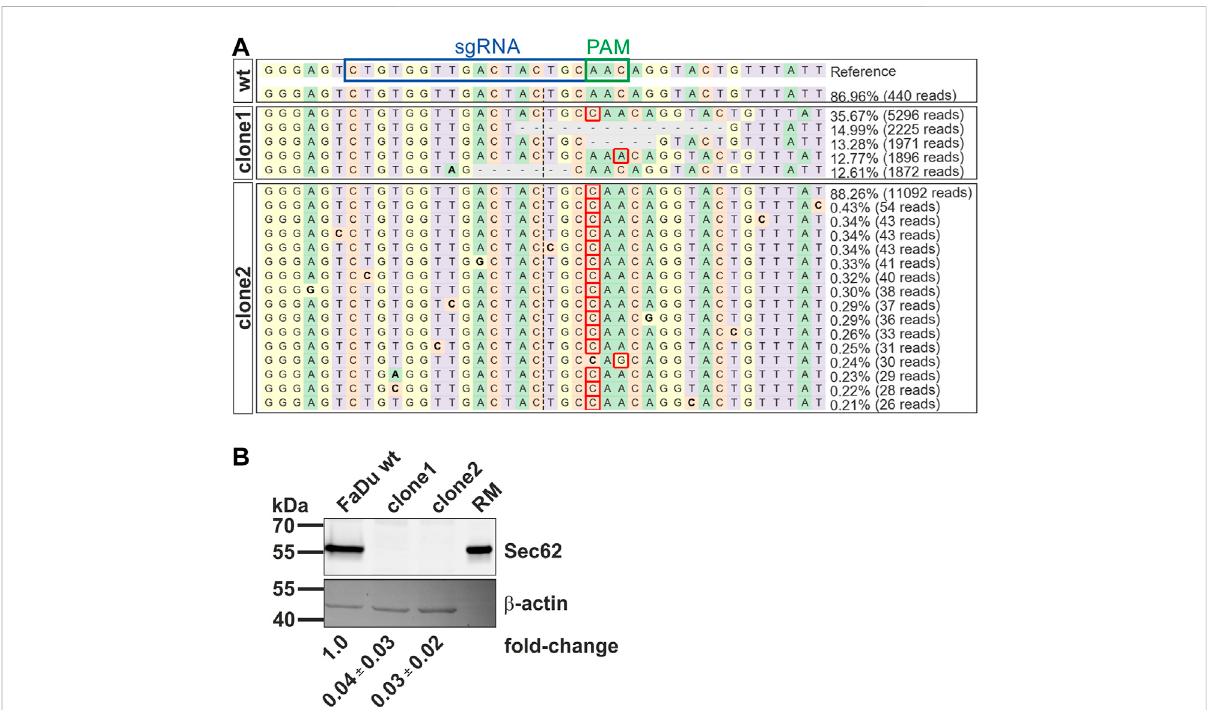
FIGURE 4 Characterization of newly generated SEC62 -knockout FaDu cell clones by CRISPR-Cas9 event. (A) Visualization of identi fi ed alleles by NGS around the Cas9 cleavage site. Each sequenced nucleotide was marked by a unique colour (A: green, C: red, G: yellow, T: purple). Insertions were marked with a red rectangle; substitutions were highlighted in bold, and deletions were marked with horizontal dashed lines. First the reference genome including the used sgRNA (blue box) and the related PAM-sequence (green box) was shown. Then the results generated by CRISPResso2 analysisofthewtsequencingandthesequencingofbothcellcloneswerelisted. (B) Cellular proteinlevelsofSEC62werequanti fi edin FaDu wt cells and SEC62 -knockout cell clones. Under the respective bands the SEC62 fold-change is indicated as a mean value ( n = 3) with the respective standard deviation. RM, rough